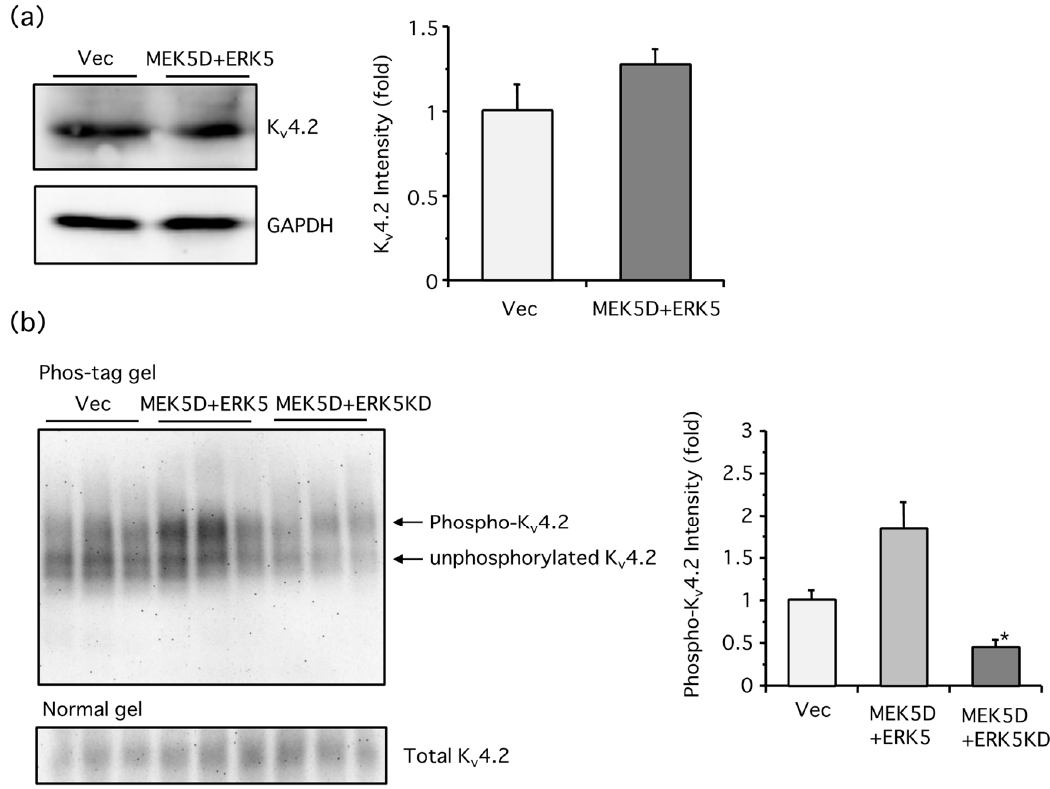
Figure 3. ERK5 did not alter the protein expression of K v 4.2, but did promote the phosphorylation of K v 4.2 in PC12 cells. ( a ) PC12 cells were transfected with empty vector (Vec) or MEK5D and ERK5. Two days after transfection, Western blotting using K v 4.2 and glyceraldehyde-3-phosphate dehydrogenase (GAPDH) antibodies was performed. The density of the K v 4.2 bands was expressed as a fold of control cells (Vec) (two independent experiments in triplicate ( n = 6 ) , unpaired Student’s t -test); ( b ) PC12 cells were transfected with empty vector (Vec), MEK5D and ERK5, or MEK5D and ERK5KD. Two days after transfection, Western blotting using Phos-tag-contained polyacrylamide gels or Phos-tag-free gels was carried out with a K v 4.2 antibody. The density of the phospho-K v 4.2 bands was expressed as a fold of the control cells (Vec). Overexpression of MEK5D and ERK5KD significantly attenuated the MEK5D and ERK5-induced K v 4.2 phosphorylation (three